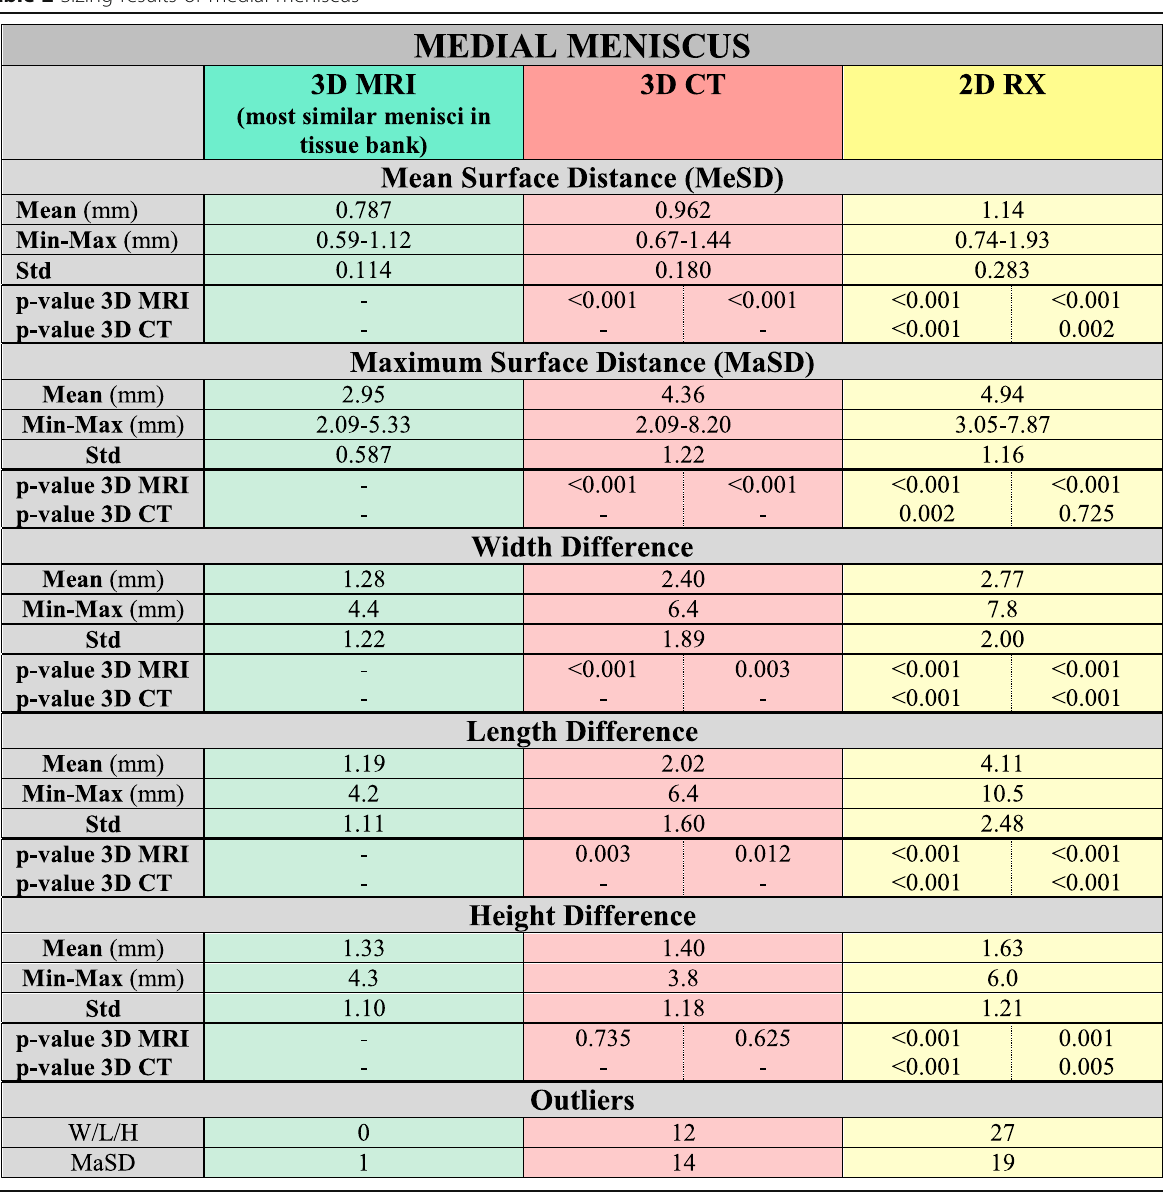
Table 2 Sizing results of medial